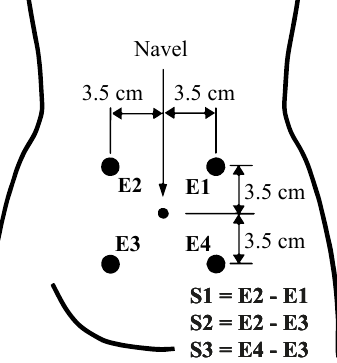
Figure 1. Recording protocol of EHG signals. Modified from